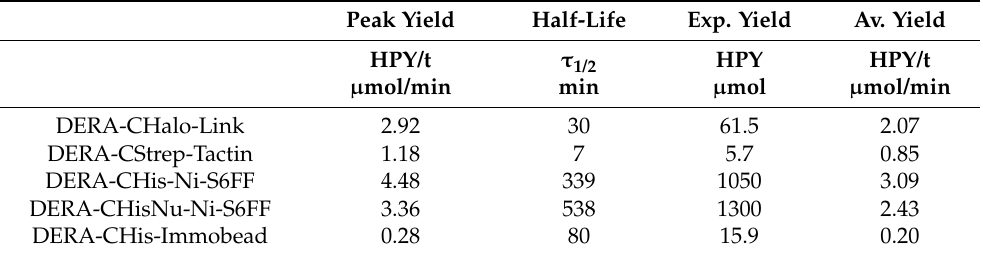
Table 1. Derived performance indicators for DERA reactors. DERA-CHalo-Link: DeoC EC -C47M-A95C with C-terminal HaloTag ® immobilized on HaloLink ® -resin. CStrep-Tactin: DeoC EC -C47M-A95C with C-terminal StrepTag immobilized on StrepTactin™-Sepharose ® . CHis-Ni-S6FF: DeoC EC -C47M-A95C with C-terminal HisTag immobilized on IMAC Sepharose ® 6 FastFlow tethered by Ni 2+ ions. CHisNu- Ni-S6FF: DeoC EC -C47M-A95C with C-terminal HisTag with additional Cysteins immobilized on IMAC Sepharose ® 6 FastFlow tethered by Ni 2+ ions. CHis-Immobead: DeoC EC -C47M-A95C with C-terminal HisTag immobilized on Immobead150P. Reactor size: ~350 µ L. Peak yield observed directly after equilibration phase. Half-life: time until peak yield is halved, starting from peak yield time point. Exp. yield: hypothetical amount of substance produced upon reaching reactor’s half-life starting from peak yield time-point. Av. yield: expected hypothetical yield averaged over half-life. Peak Yield